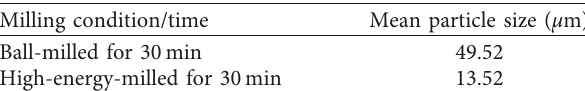
Figure 5: XRD pattern of duck eggshell+A-TiO 30min and (b) high-energy-milled for Table 1: Mean particle size of mixed duck eggshell +A-TiO tained from different milling processes.